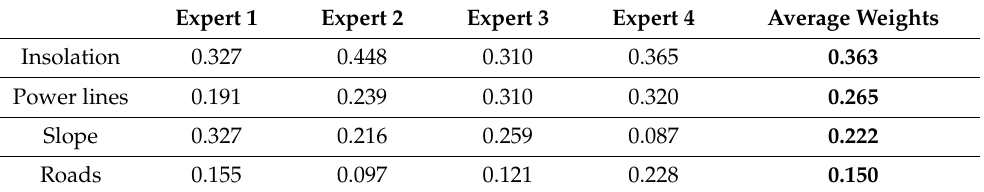
Table 1. Average weights of the Aptitude criteria.